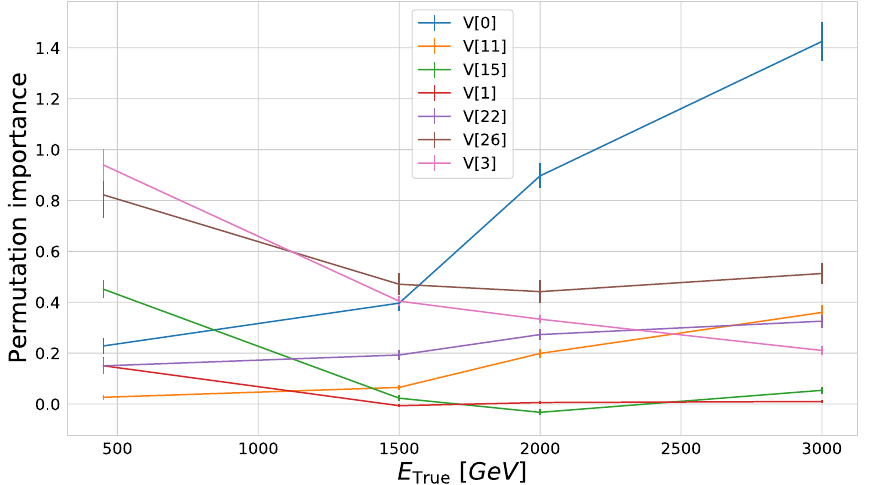
Fig. 13 Permutationimportanceofthemostimportantfeaturesaseval- uated using the “HL-feats. only” model in bins of true energy. The features, described further in Sect. 6 are: V[0] – E-sum in cells above 0.1 GeV, V[1] – fractional MET, V[3] – overall 2nd moment of trans- Fig. 14 Resolutions of the models with varying input menus. Resolution is computed on the holdout-validation data in bins of true